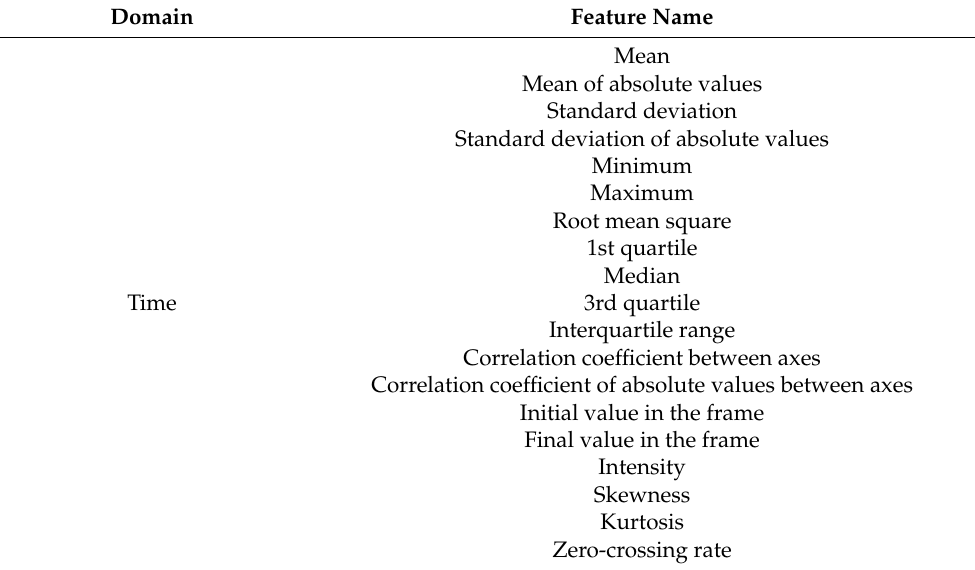
Table 3. List of